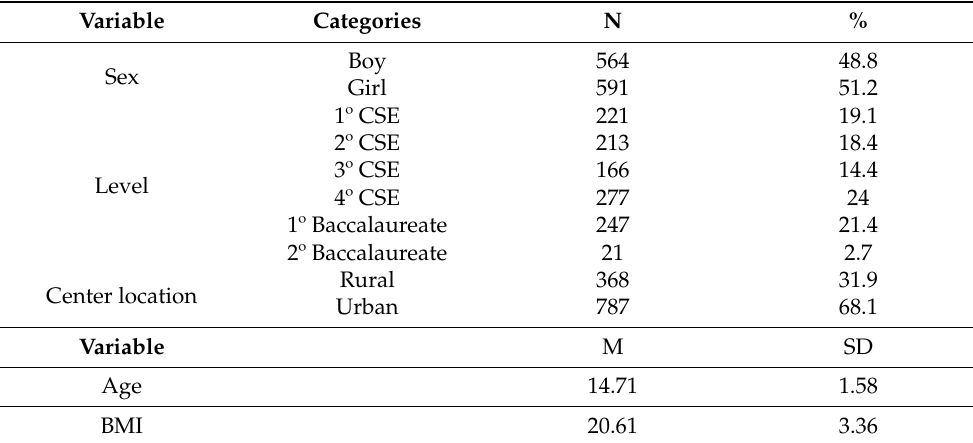
Table 1. Sample characterization (N =